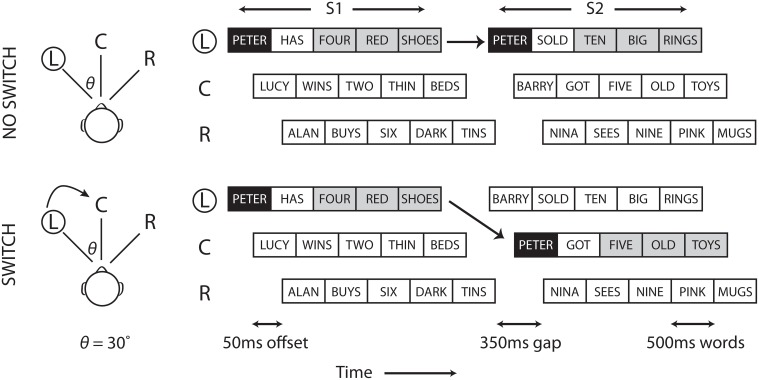
Experimental setup. Matrix sentences were presented over loudspeakers positioned to the left (L), center (C), and right (R) of the listener's head. Examples are shown for a single no switch (top), and switch (bottom) trial. Subjects attended to the cued location (circled) and followed sentences (S1 and S2) with the cued name, in this case “Peter”. In Experiment 1, subjects were required to verbally recall the last three words of each target sentence (gray). In Experiment 2, subjects answered a graded multiple choice question related to the target sentences.